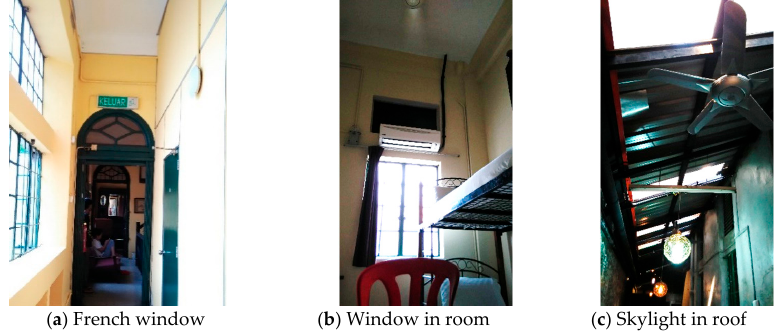
Figure 8. Architectural features in Building A.